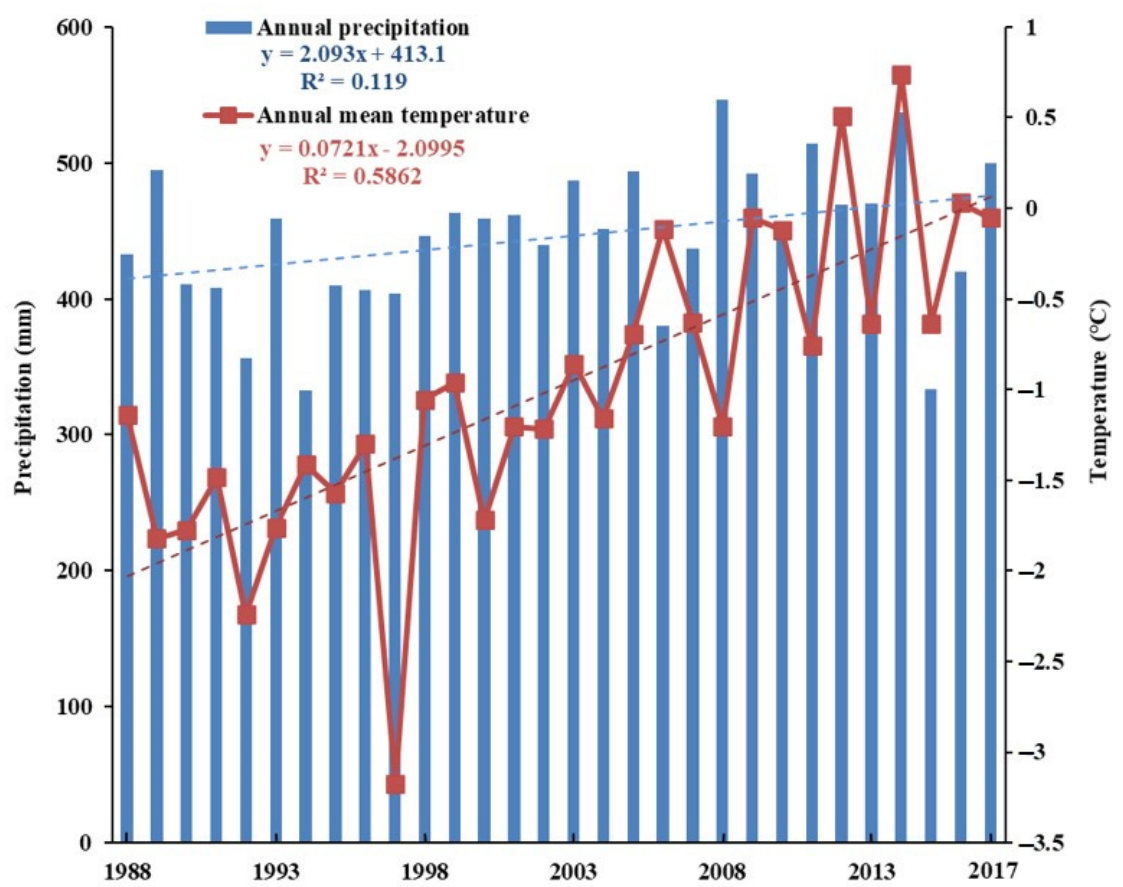
Figure 3. Changes of the annual mean temperature and annual precipitation around the study area during 1988–2017. Table 2. The Pearson’s correlation coefficients for lake-area and precipitation/temperature values. Period Lake Annual Mean Temperature Annual Precipitation